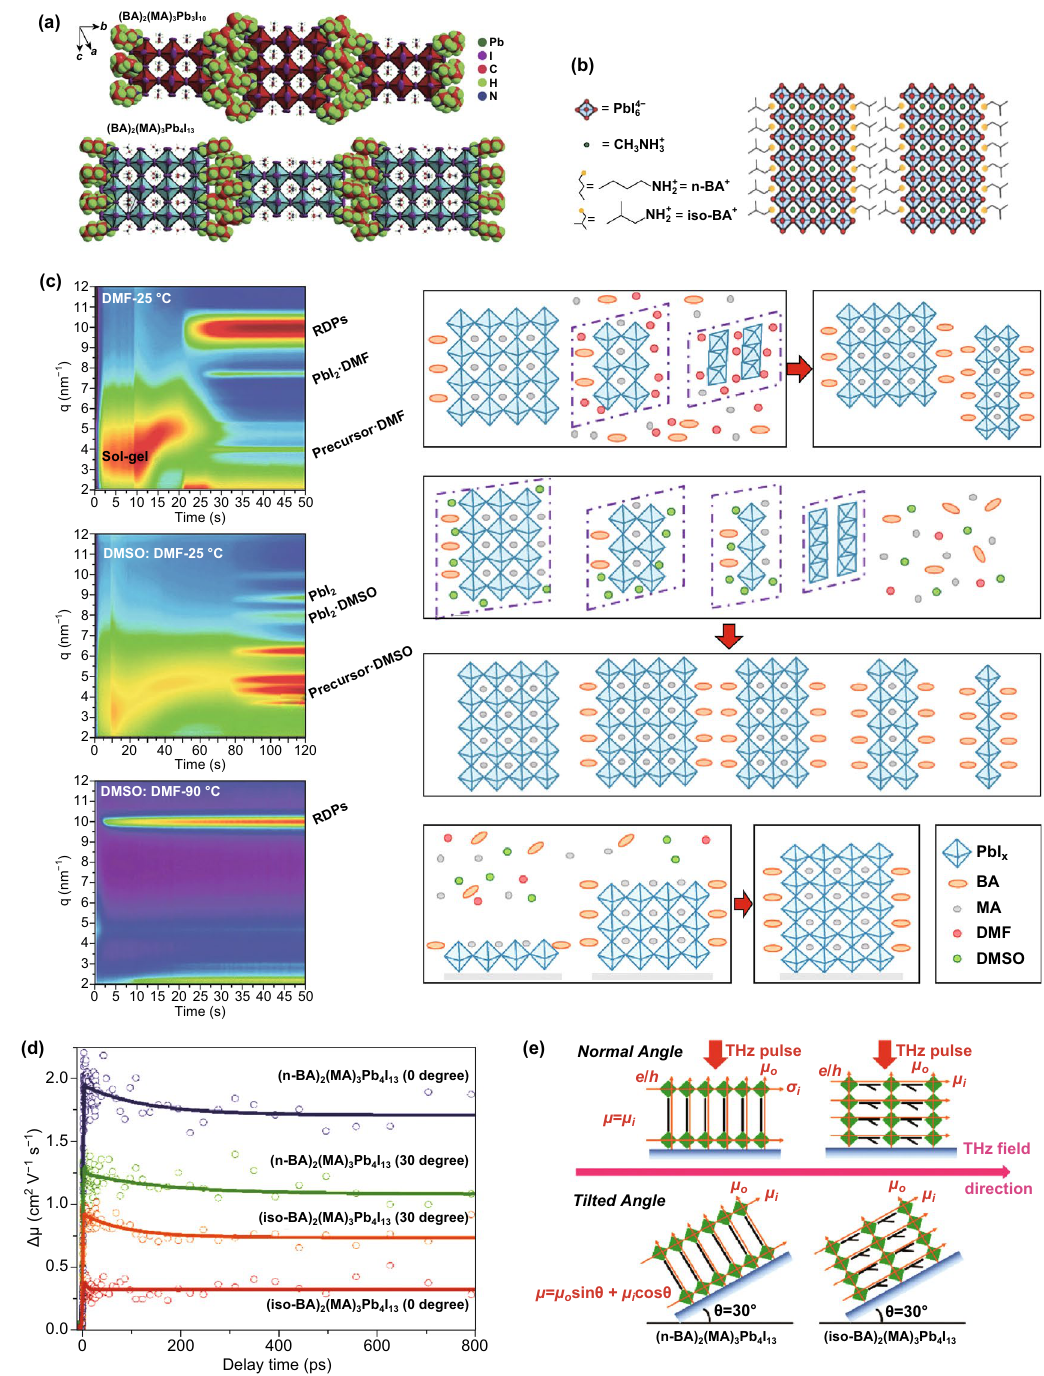
Fig. 7 Schematic illustration of perovskite crystal structures: a (BA) 2 (MA) 3 Pb 4 I 13 and (BA) 2 (MA) 3 Pb 4 I 13 ; b (iso-BA) 2 (MA) 3 Pb 4 I 13 . Copy- right © 2017 WILEY-VCH Verlag GmbH & Co. KGaA, Weinheim. c In situ GIWAXS measurements and schematic models [87]. Copyright © 2018 WILEY-VCH Verlag GmbH & Co. KGaA, Weinheim. d The photoconductivity kinetics from TRTS for RT (n-BA) 2 (MA) 3 Pb 4 I 13 and (iso-BA) 2 (MA) 3 Pb 4 I 13 films excited at 400 nm under an excitation density of 3.4 × 10 13 ph cm −2 pulse −1 with a different pump-probe geometry at both normal positions. e Schematics of the composition of the charge mobility detected by TRTS with different incident angles of THz probe pulse for two samples. Copyright © 2017 WILEY-VCH Verlag GmbH & Co. KGaA,